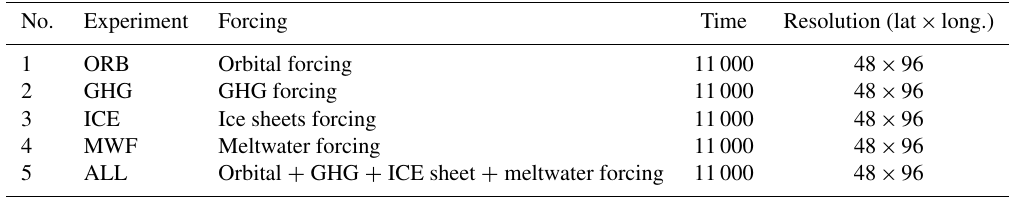
Table 1. TraCE-21ka simulation experiments. No. Experiment Forcing Time Resolution (lat ×